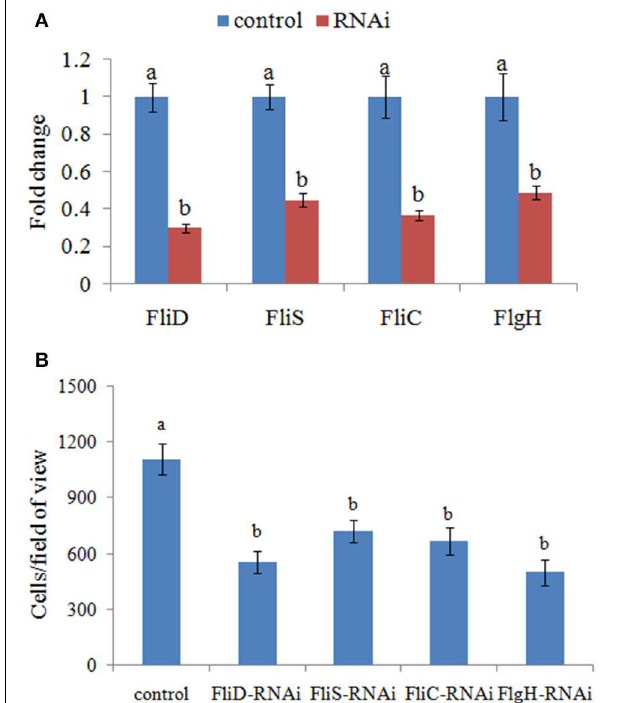
FIGURE 3 | Transient RNAi reduced the adhesion of V. alginolyticus . (A) QPCR analysis of the expression of FliD , FliC , FlgH , and FliS after transient gene silencing at 2h in comparison to the control. The data are presented as the means ± S.D. ( n = 6 ).The means of the treatments not sharing a common letter are significantly different at P < 0 . 05 . (B) The adhesion capacity to mucus of transient silenced V. alginolyticus at 2h. The data are presented as the means ± S.D. ( n = 3 ). The means of the treatments not sharing a common letter are significantly different at P < 0 . 05 , as assessed using One-Way ANOVA followed by Dunnett’s